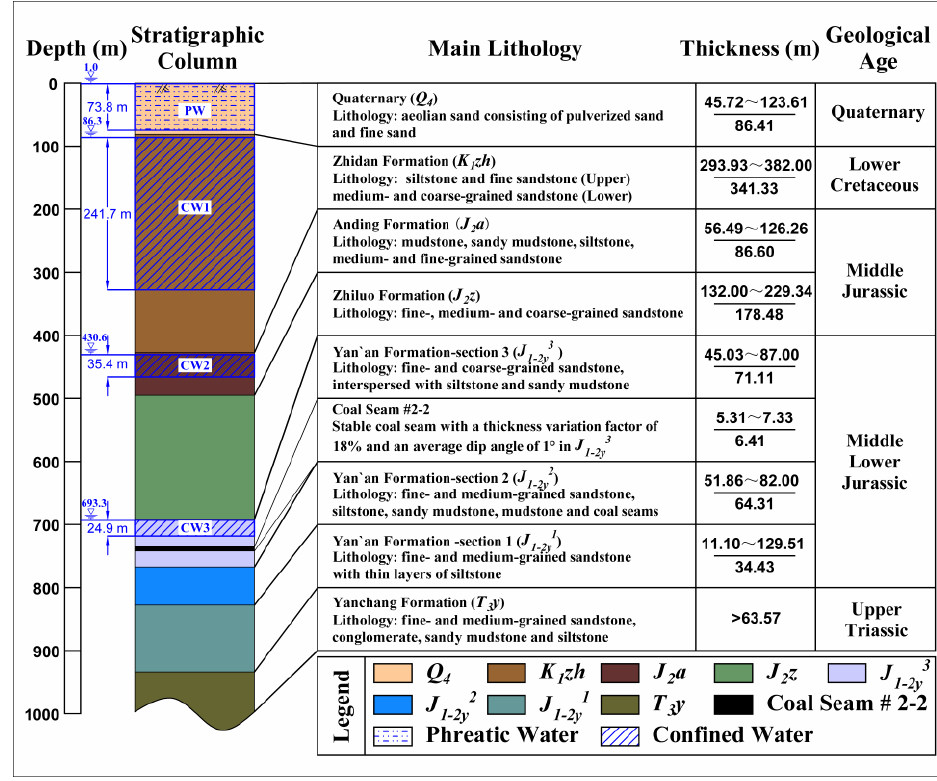
Figure 2. Stratigraphic structure and aquifer distribution in the study